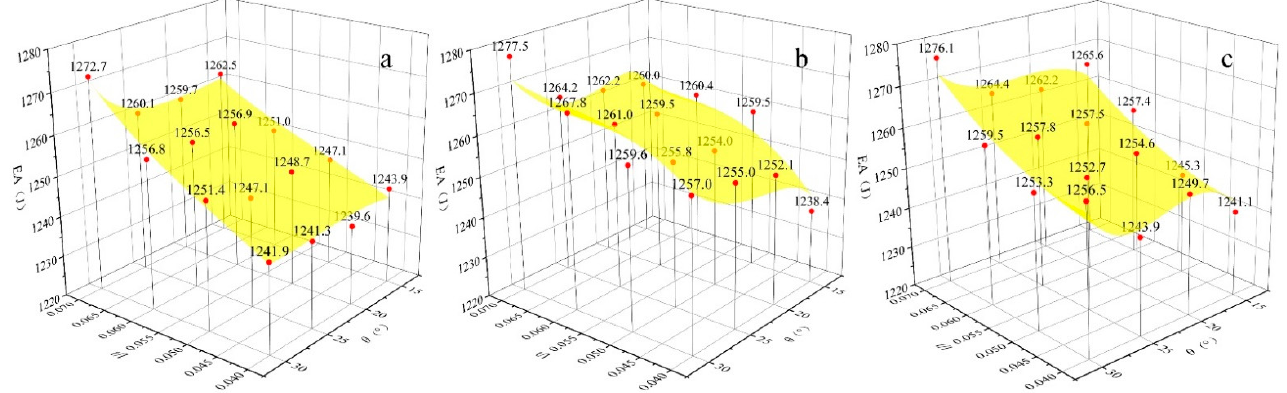
Figure 9. Energy absorption of the honeycomb structure with different Poisson’s ratios at 100 m/s impact speed: ( a ) Poisson’s ratio is positive; ( b ) Poisson’s ratio is negative; ( c ): Poisson’s ratio is zero.